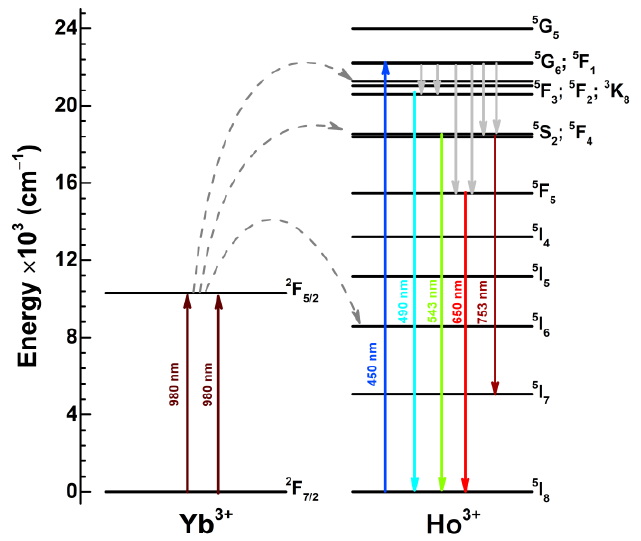
Figure 4. Schematic energy level diagram of energy transitions in Yb 3+ and Ho 3+ .